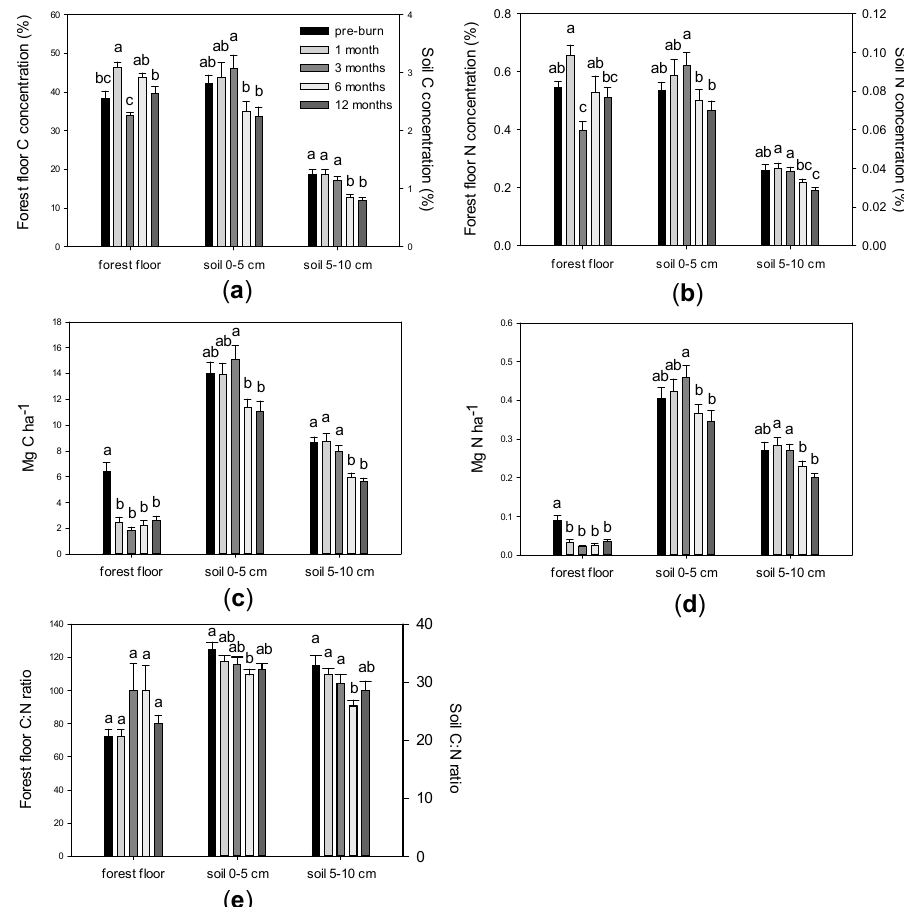
Figure 3. C and N concentrations ( a , b ), C and N pools ( c , d ) and C:N ratios ( e ) of forest floor and soil collected pre-burn and 1, 3, 6, and 12 months after the fire. Within each group, means with the same letter do not differ at p < 0.05 and error bars represent the standard error of the mean. Note that a , b and e have separate x axes scaled for forest floor and soil, respectively.